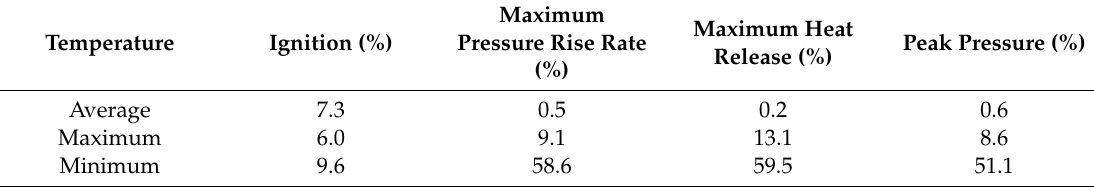
Table 5. Error of typical temperature based on CMS of series